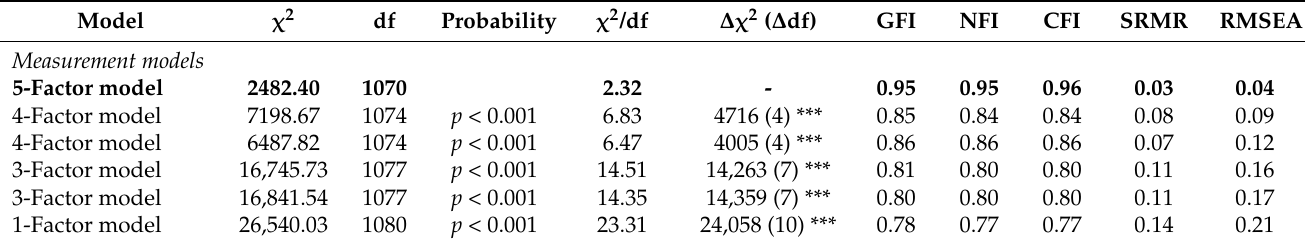
Table 2. Confirmatory factor analysis results.